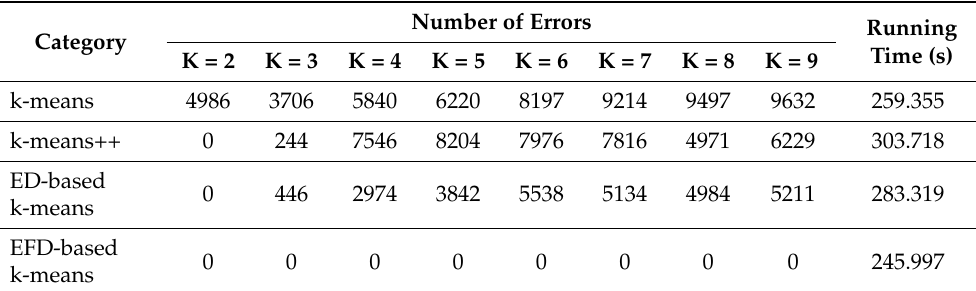
Table 3. Comparison of the effects of four clustering methods on the number of errors and the running time.